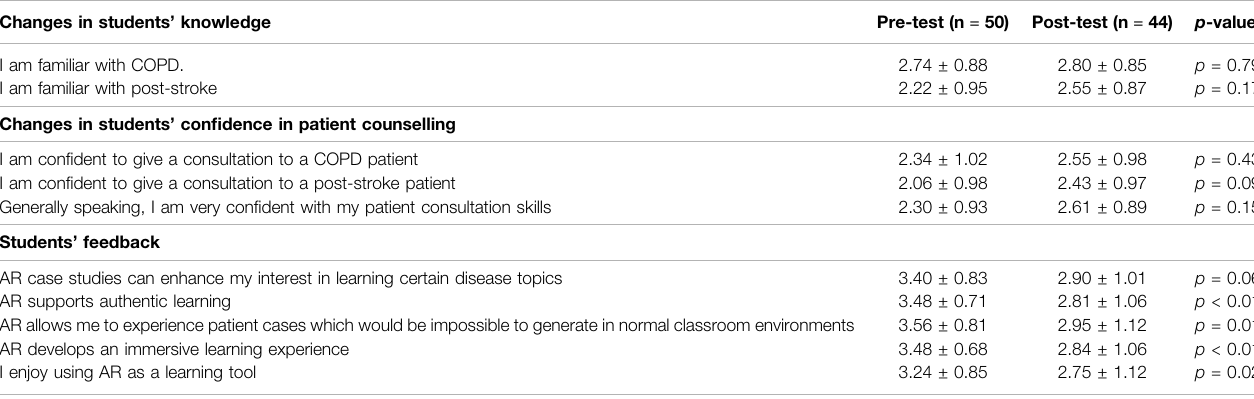
TABLE 1 | Student ’ s feedback on AR micro modules. Changes in students ’